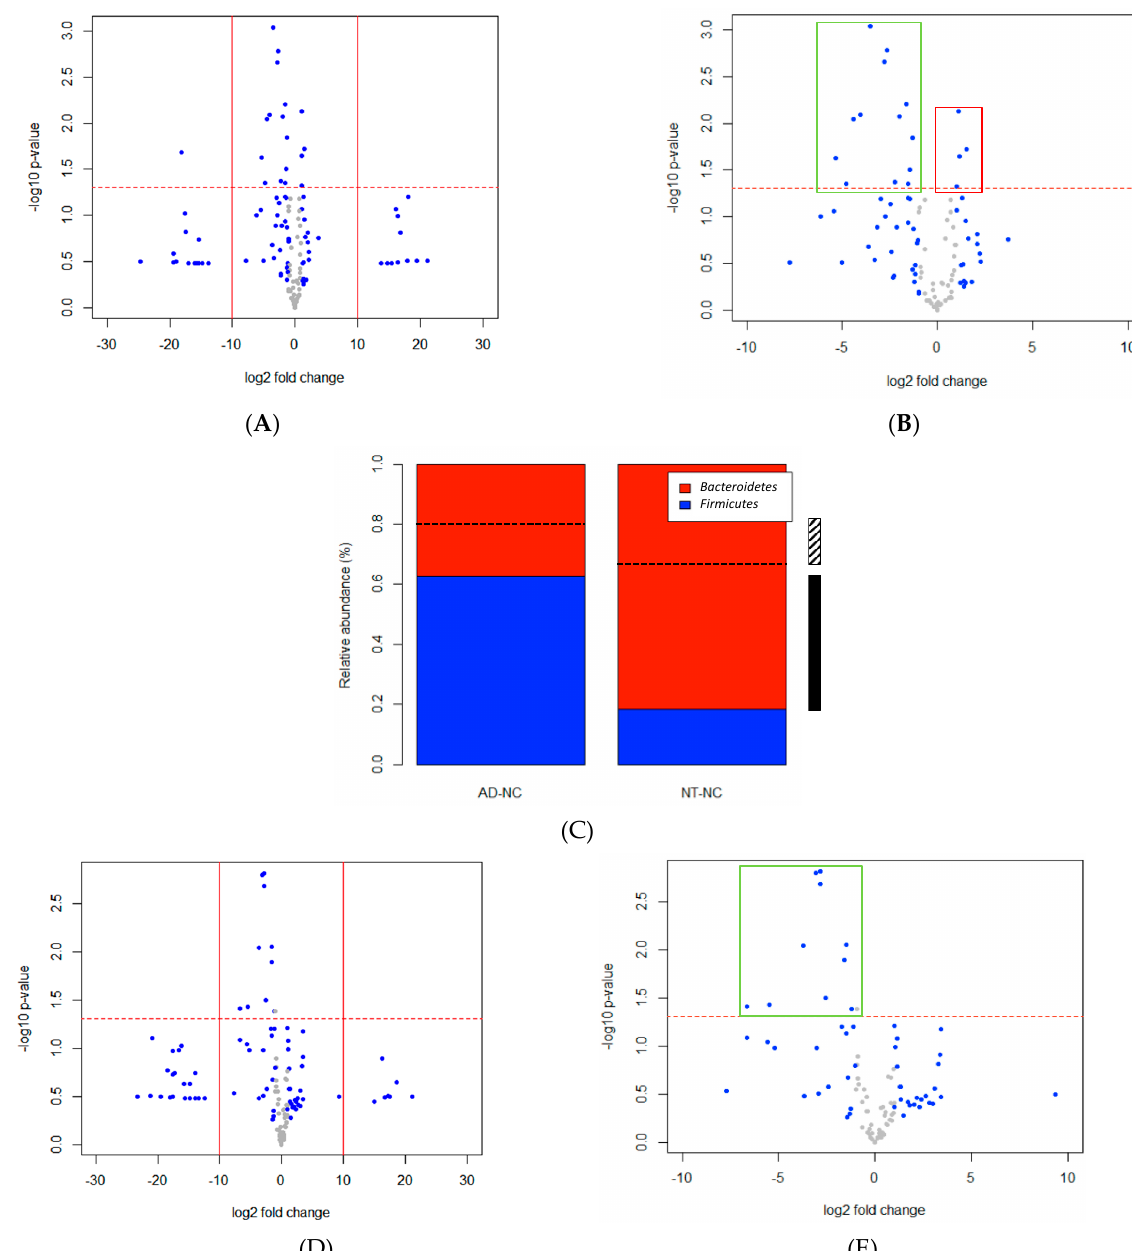
Figure 2. Volcano plots showing the differences of gut microbiota in ( A ) NT-NC versus AD-NC (Ga) and ( D ) NT-NC versus NT-C (Gc). A negligible number (Ga: 0.000002; NT-NC in Gc: 0.000002, NT-C in Gc: 0.000005) was added to the mean abundance of every bacterium to avoid the value of magnitude of fold change being infinitely large or small. The numbers were calculated based on one hundredth of the minimal relative abundance in each group. Each point represents a bacterium with its magnitude fold change (log2 of relative abundance) on the x -axis and the value of statistical significance ( − log10 of p value) on the y -axis. The dashed red line shows where p = 0.05, with points above the line having p < 0.05 and points below the line having p > 0.05. Points having magnitude of fold change less than 1 are shown in grey. Points outside of the solid lines are bacteria with 0 abundance in one of the groups. Volcano plots of Ga ( B ) and Gc ( E ) with log2 fold change from − 10 to 10 show degree of magnitude in relative abundance of bacteria substantially greater in decreasing (green box) than increasing (red box). ( C ) Mean relative abundances (%) of Firmicutes and Bacteroidetes in AD-NC and NT-NC subjects. Dashed lines show the approximate ratios of Firmicutes in Strati et al. when comparing ASD to NT. Differences of ratios of Firmicutes between groups are shown in stripy (AD vs. NT in Strati et al. [13] ) and solid bars (AD-NC vs. NT-NC). AD: individuals with autism spectrum disorders; NT: neurotypical individuals; C: constipated; NC: non-constipated.